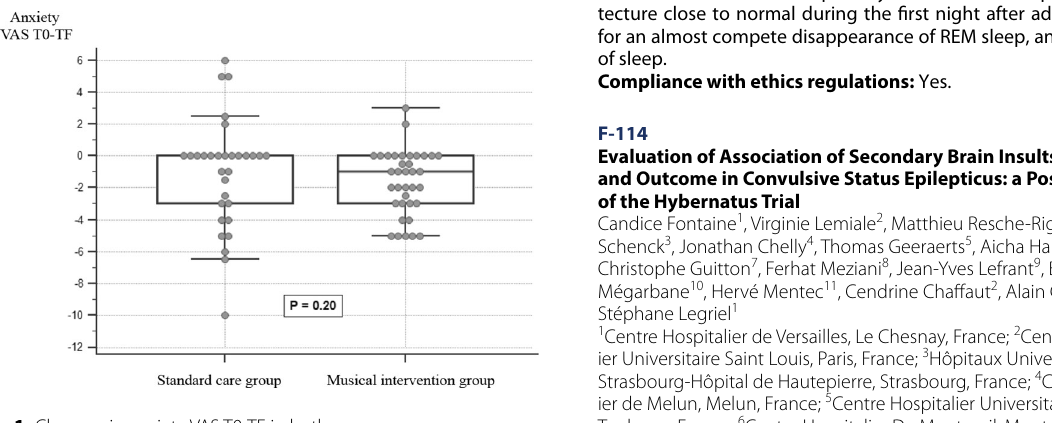
Fig. 1 Changes in anxiety VAS T0‑TF in both